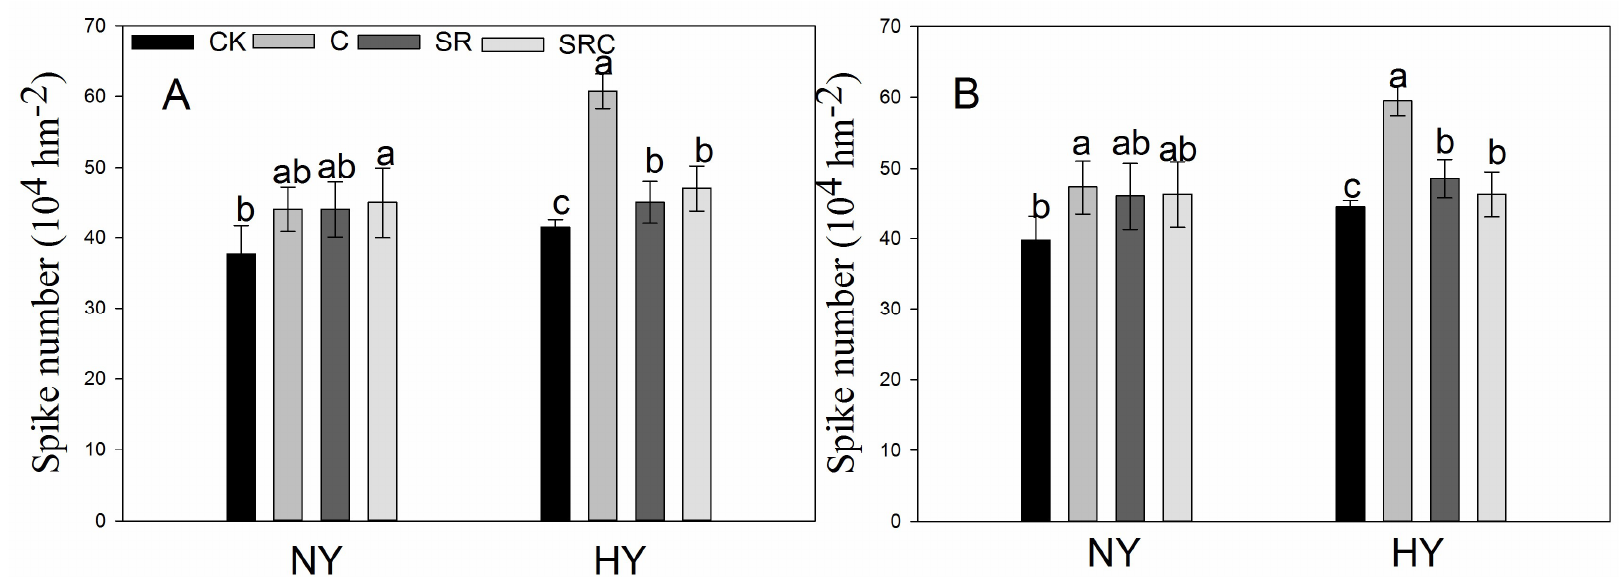
Figure 3. Effect of biochar and soft rock treatments on the spike number in two fertilizer levels conducted in 2018 ( A ) and 2019 ( B ). CK, sand only; C, sand and biochar; SR, sand and soft rock; SRC, sand, biochar, and soft rock; NY, normal yield pattern; HY, high yield pattern. Data were shown in mean ± SE. Different letters indicate significant differences ( p < 0.05).